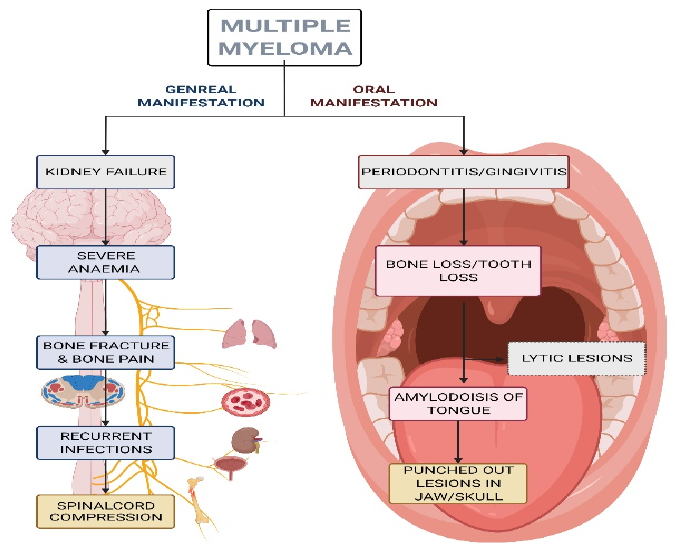
Figure 2 . Schematic diagram showing general and oral manifestations of multiple myeloma. This figure was created with Biorender.com (accessed on 9 September 2022).